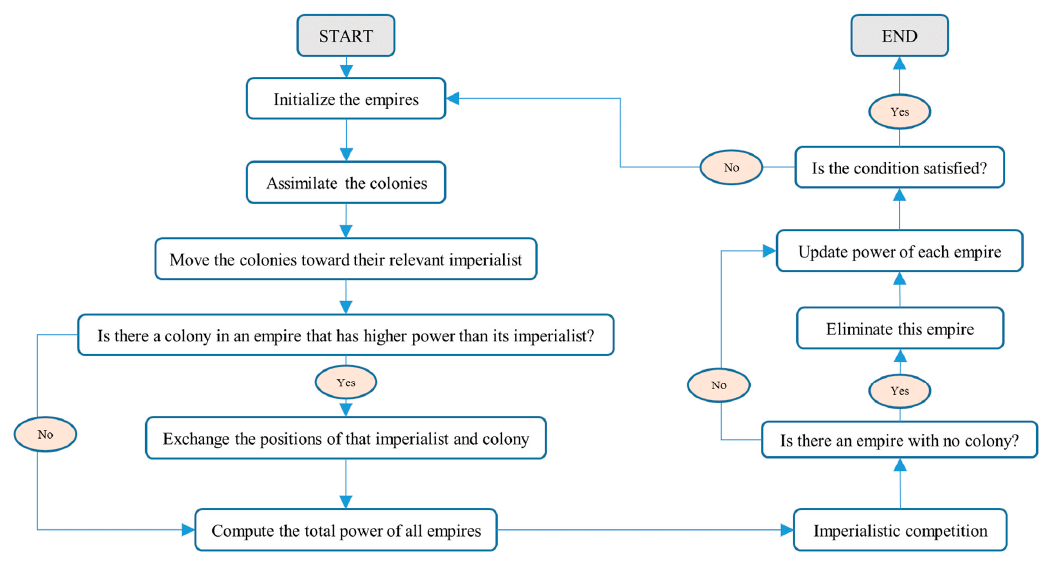
Figure 2. Flowchart of the imperialist competitive algorithm (ICA).